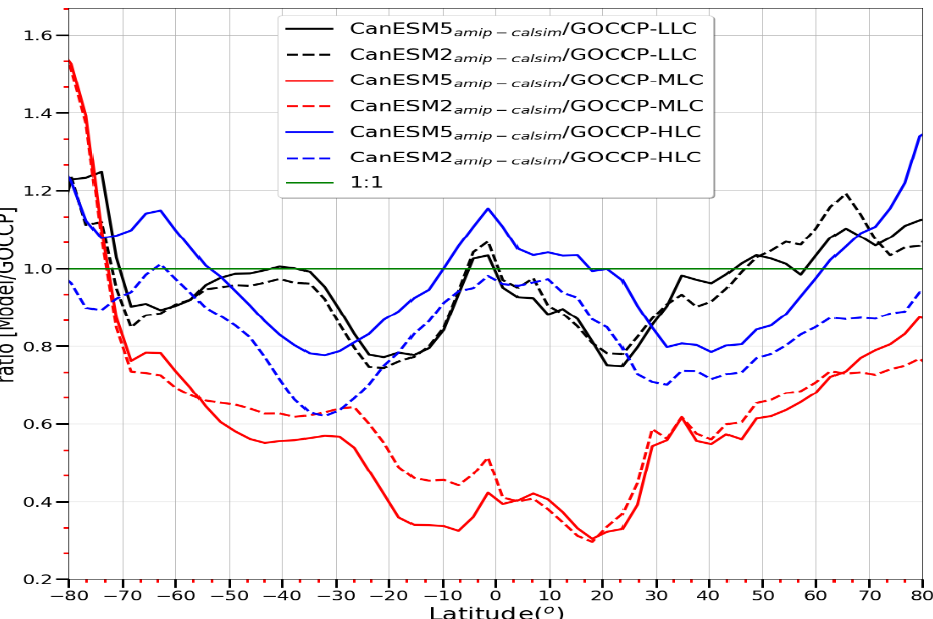
Figure 7. Ratios (Model/GOCCP) of the annually and zonally averaged modeled low-level, mid-level, and high-level CFs to the corresponding observed values.